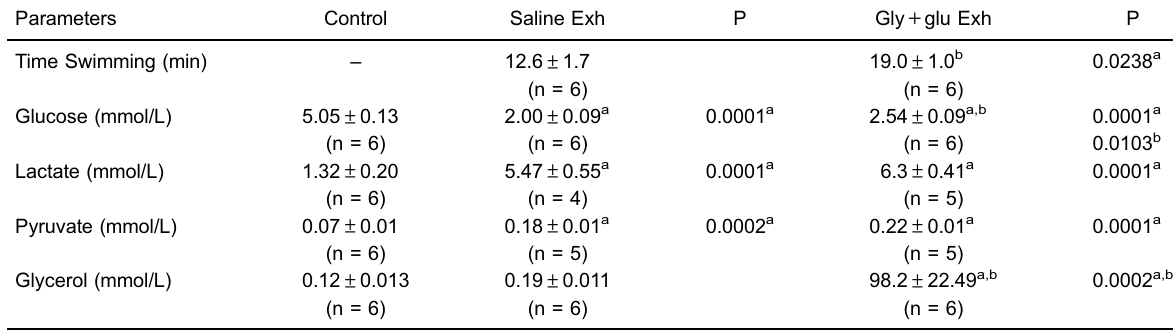
Table 3. Swimming time and blood glucose, lactate, pyruvate, and glycerol levels in 15-h fasted rats that received oral (gavage) saline (1 mL) or glycerol (0.63 g/kg) + glucose (0.25 g/kg), 20 min before the onset of forced swimming to exhaustion (Exh).